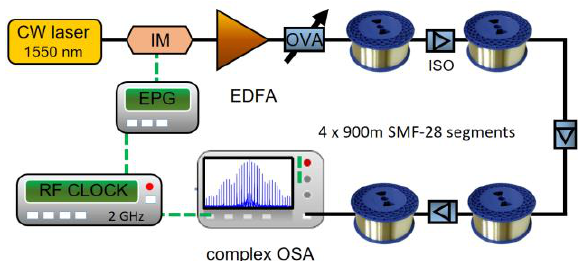
Fig. 1. Experimental setup . CW : continuous wave; IM : intensity modulator; EPG : electronic pattern generator; EDFA : erbium doped fiber amplifier; ISO : isolator ; OVA : optical variable